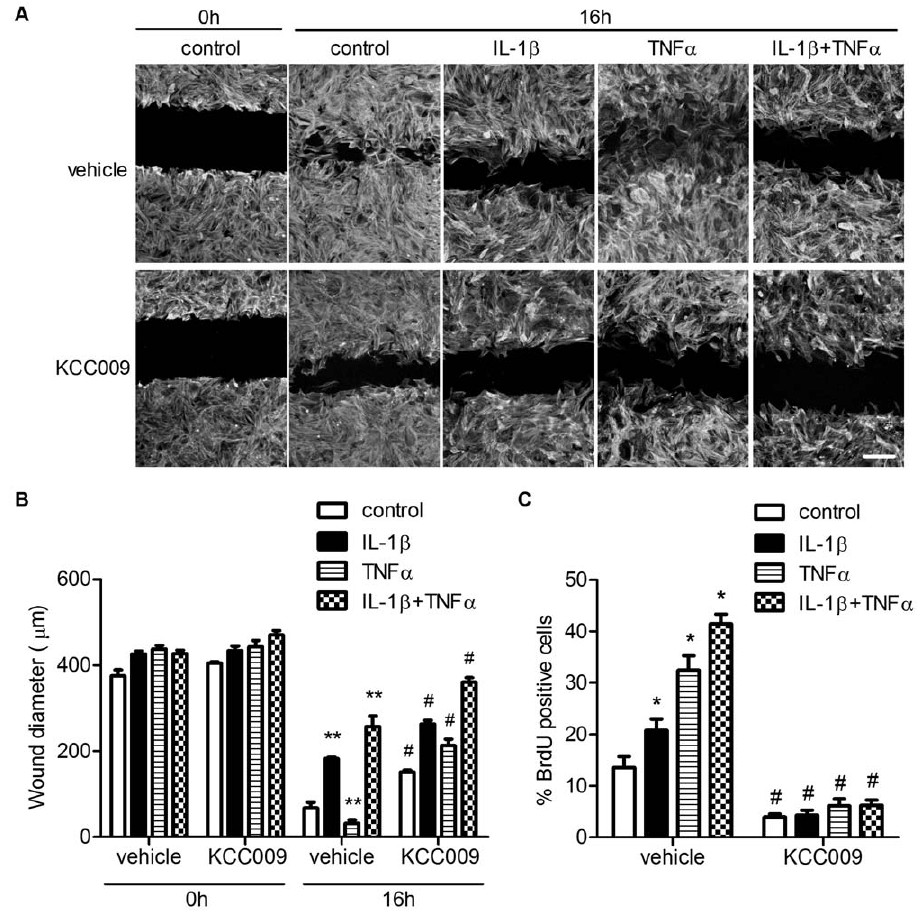
Figure 5. The effect of cytokine treatment and inhibition of TG2 activity on the migration capacity of astrocytes. A ) A scratch wound was made in an astrocyte confluent cell layer plated onto Fn and astrocytes were allowed to migrate in the presence of vehicle or 0.5 mM KCC009. Cells were fixed after 0 and 16 h and stained with rhodamine-phalloidin to visualize the cells and wound diameter. Scale bar: 200 m m. B ) Quantification of wound diameter after migration of rat astrocytes. Astrocytes were allowed to migrate for 16 h and the surface of the wound was quantified using phase-contrast microscopy after 0 and 16 h. C ) BrdU incorporation after cytokine treatment and subsequent TG2 inhibition. Data represent mean + s.e.m. from a single experiment using 5 measurements per condition/time point and is representative out of 3 separate experiments. *P , 0.05 versus vehicle-treated control cells, **P , 0.01 versus vehicle-treated control cells, # P , 0.01 versus vehicle-treated control or matched cytokine-treated cells.